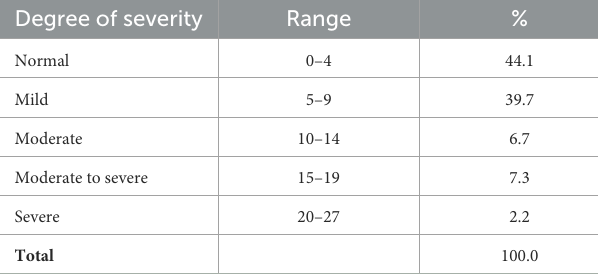
TABLE 1 Level of severity of PHQ9 in the sample of